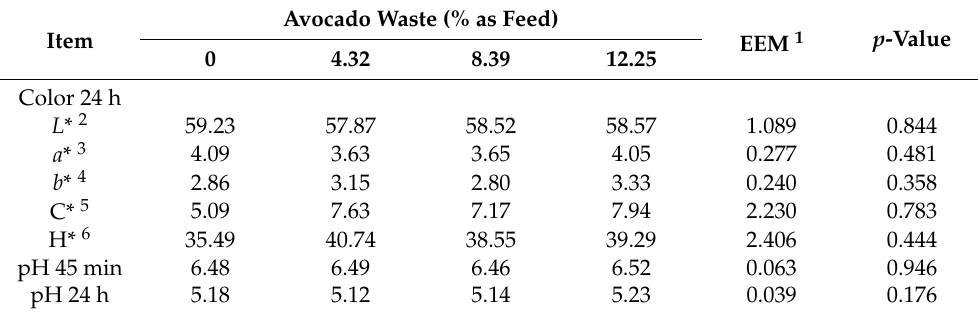
Table 4. Color and pH values of the Longissimus thoracis et lumborum muscle of fattening rabbits fed diets with different levels of avocado